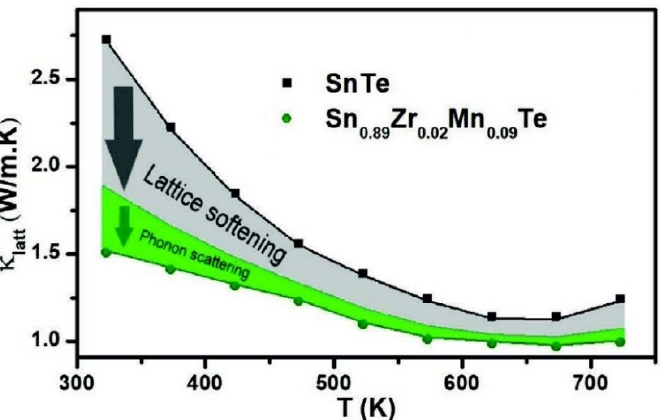
Figure 6. Contribution of the lattice softening effect versus phonon scattering effect to lower thermal conductivity in SnTe [70].